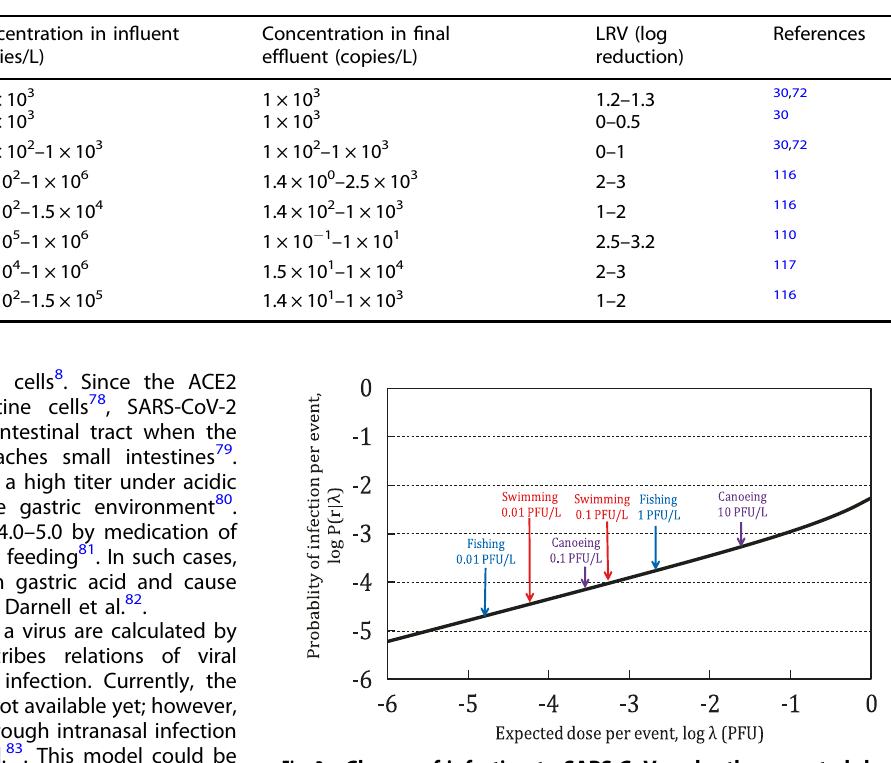
Fig. 3 Chance of infection to SARS-CoV under the expected dose of virus per exposure event. Bold line shows the probability of infection as a function of the expected viral dose. Arrows point to the probability of infection and expected viral dose in various water activities under different scenarios of viral concentration in